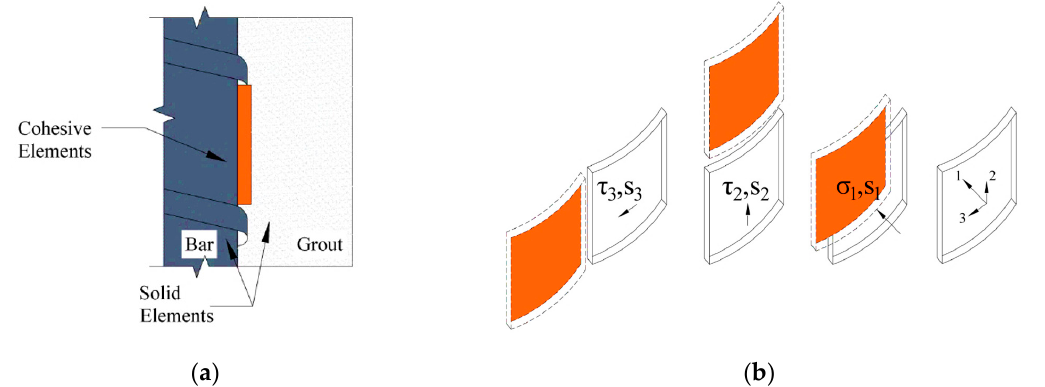
Figure 4. ( a ) Bond modeling using interfacial elements; ( b ) interface coordinates, stresses, and relative displacements.